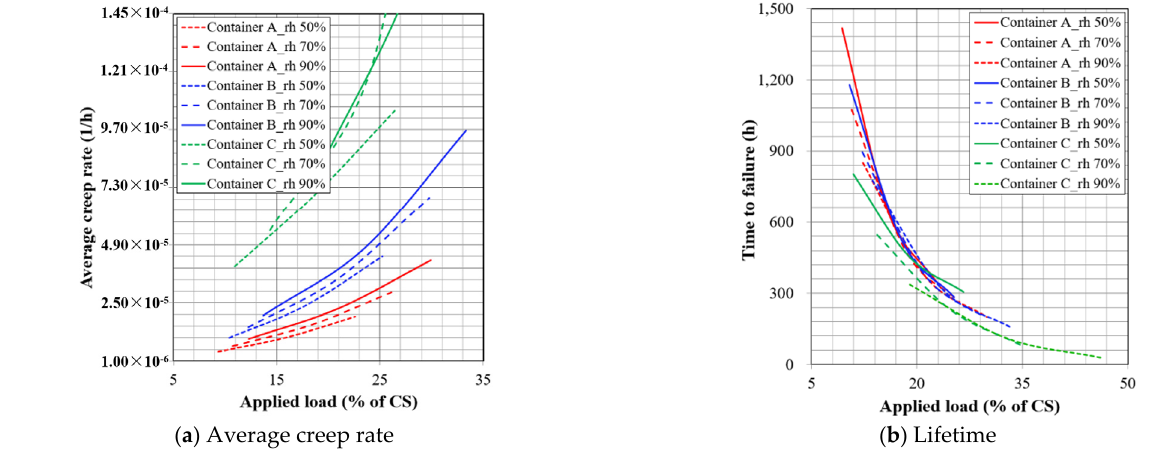
Figure 6. Average creep rate and lifetime with respect to relative humidity and applied load for the target shipping containers.